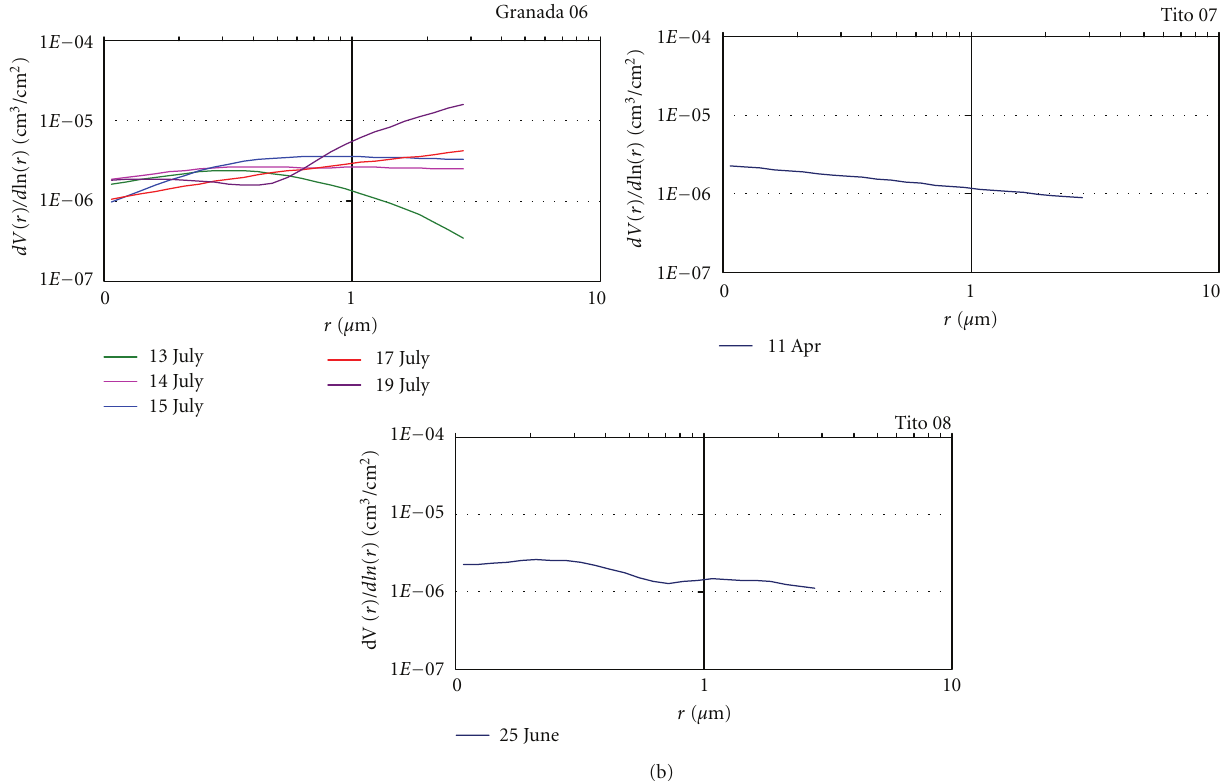
Figure 4: (a) Retrieved dust size distributions corresponding to α ≤ 0.5 and (b) dust size distributions corresponding to α > 0.5.